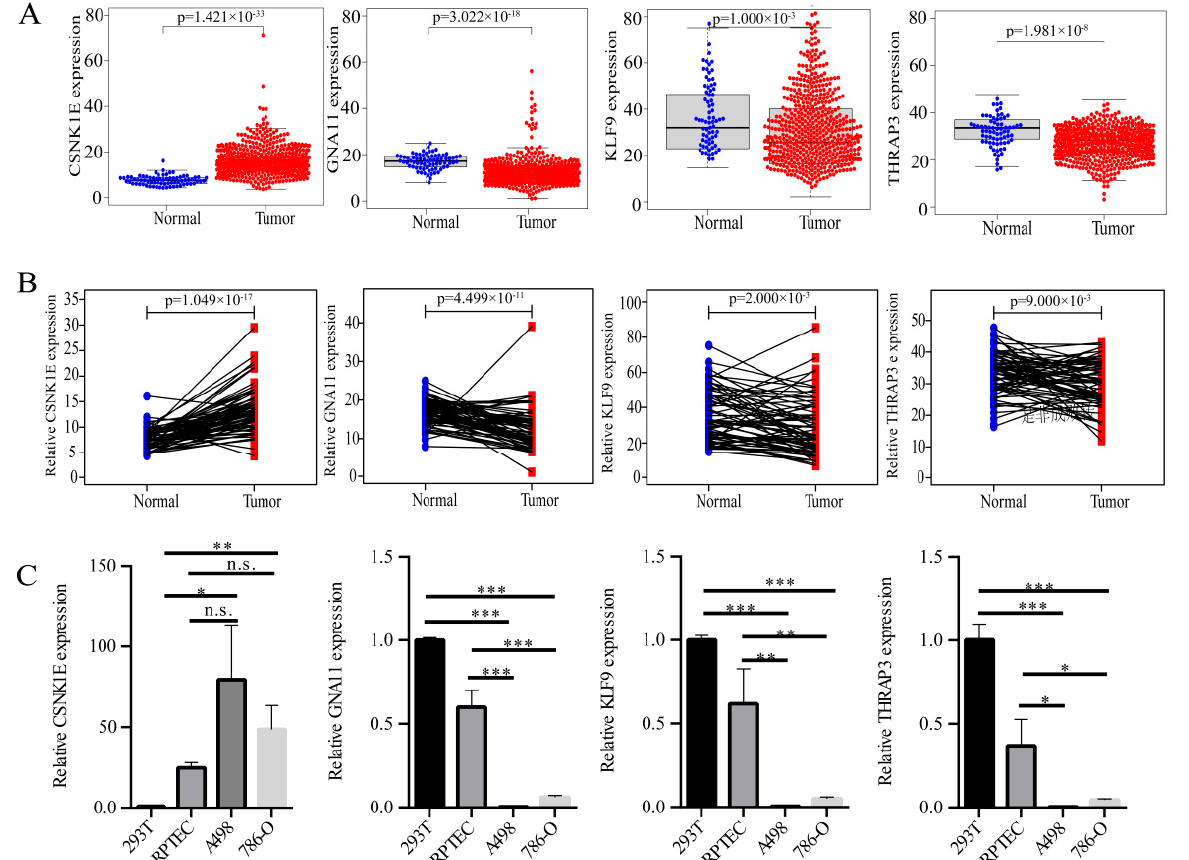
Figure 5. The expression levels of DERGs. ( A ) CSNK1E, GNA11, KLF9, and THRAP3 mRNA levels in 539 KIRC samples and 72 normal samples; ( B ) CSNK1E, GNA11, KLF9, and THRAP3 mRNA levels in KIRC and paracancerous tissues (72 pairs samples); ( C ) CSNK1E, GNA11, KLF9, and THRAP3 mRNA levels in KIRC cells （ A498 and 786-O ） and control cells （ 293T and RPTEC ） were determined by qRT-PCR (n ≥ 3). The standard deviation (SD) of the mean was represented by the error bars. Student’s t test. *** p < 0.001, ** p < 0.01, * p < 0.05.